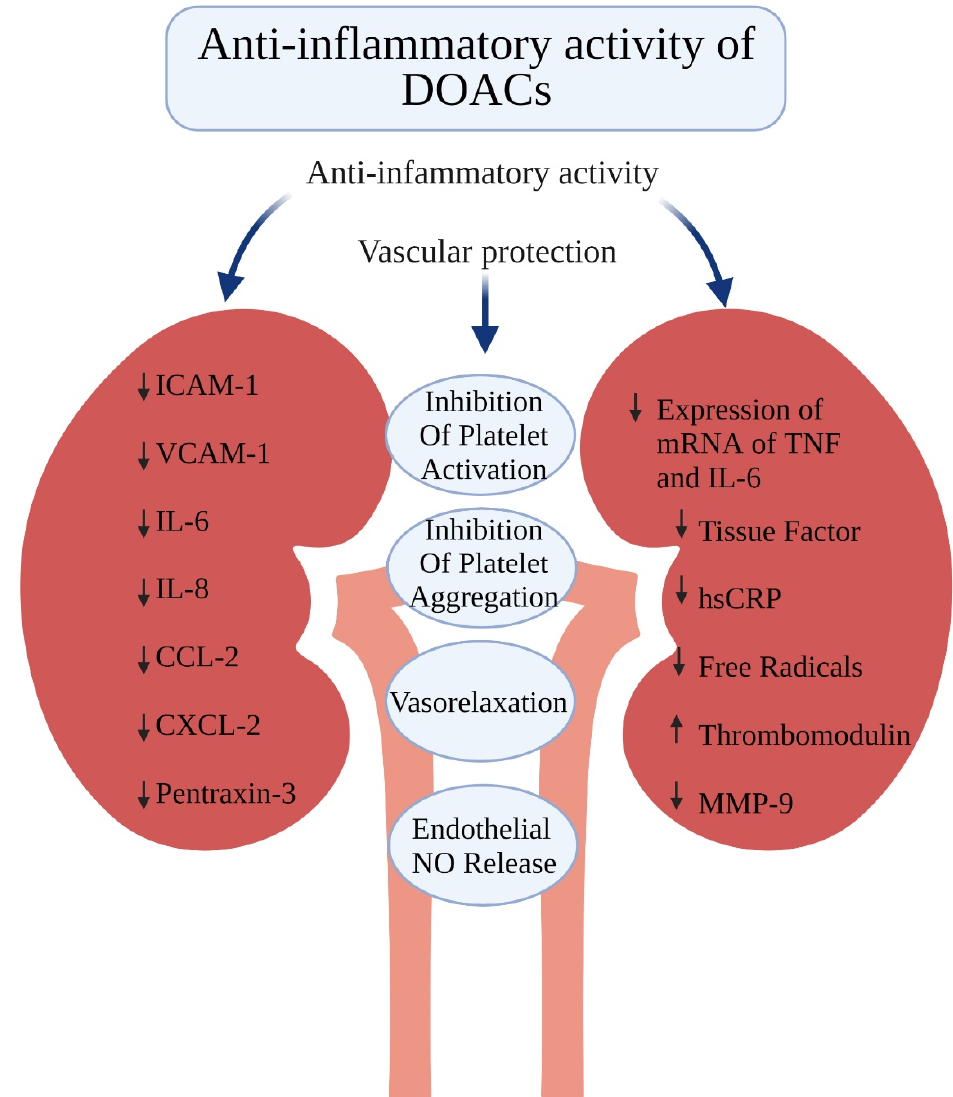
Figure 3. Pleiotropic effects of direct oral anticoagulants. Created with BioRender.com .